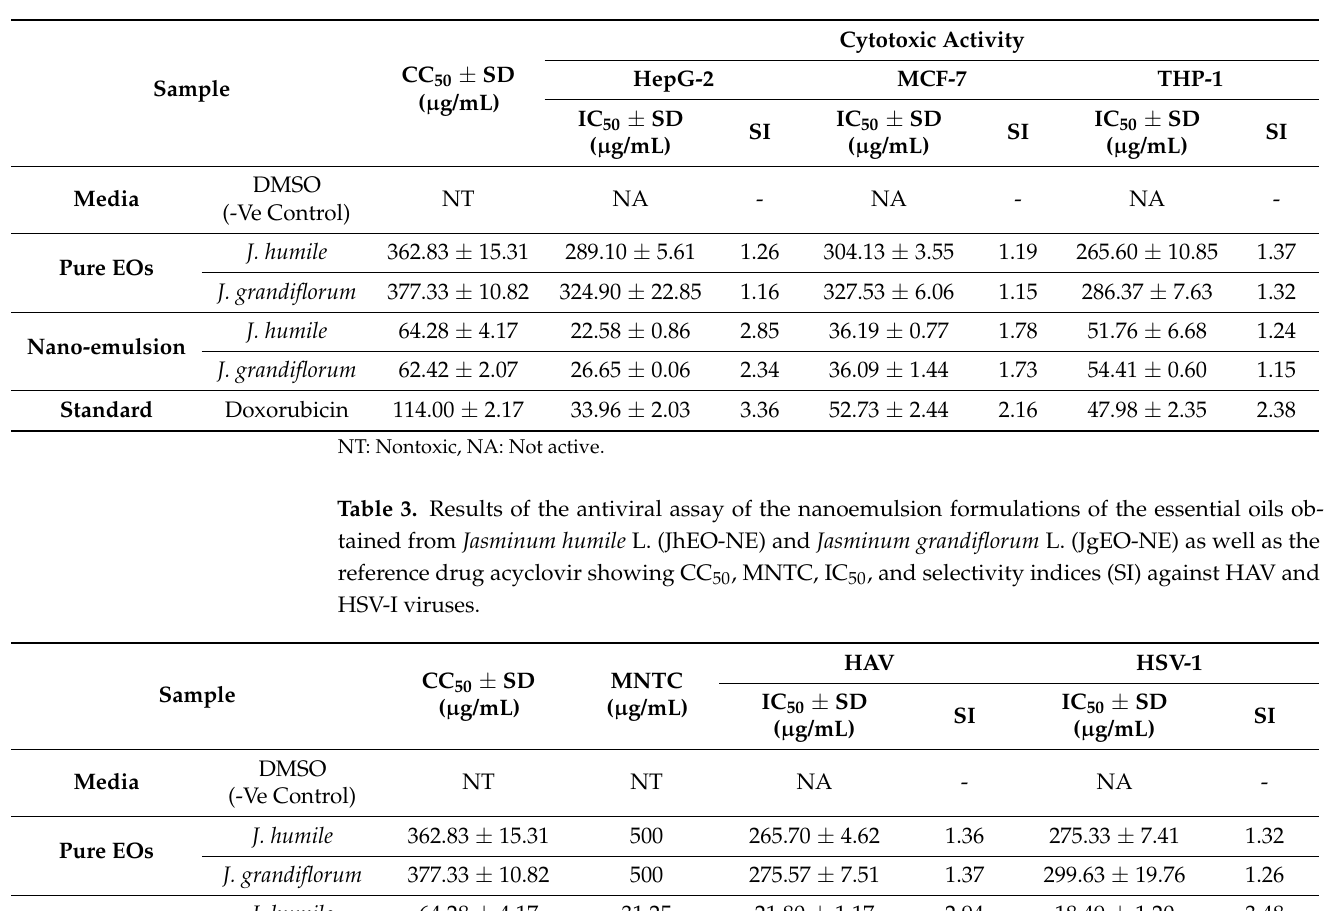
Table 2. Cytotoxic activity of the nanoemulsion formulations of the essential oils obtained from J. humile (JhEO-NE) and J. grandiflorum (JgEO-NE) as well as the reference drug doxorubicin, against